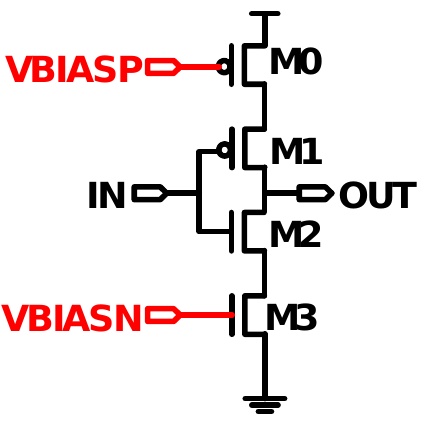
Figure 6. A current-starved/voltage-controlled delay cell.